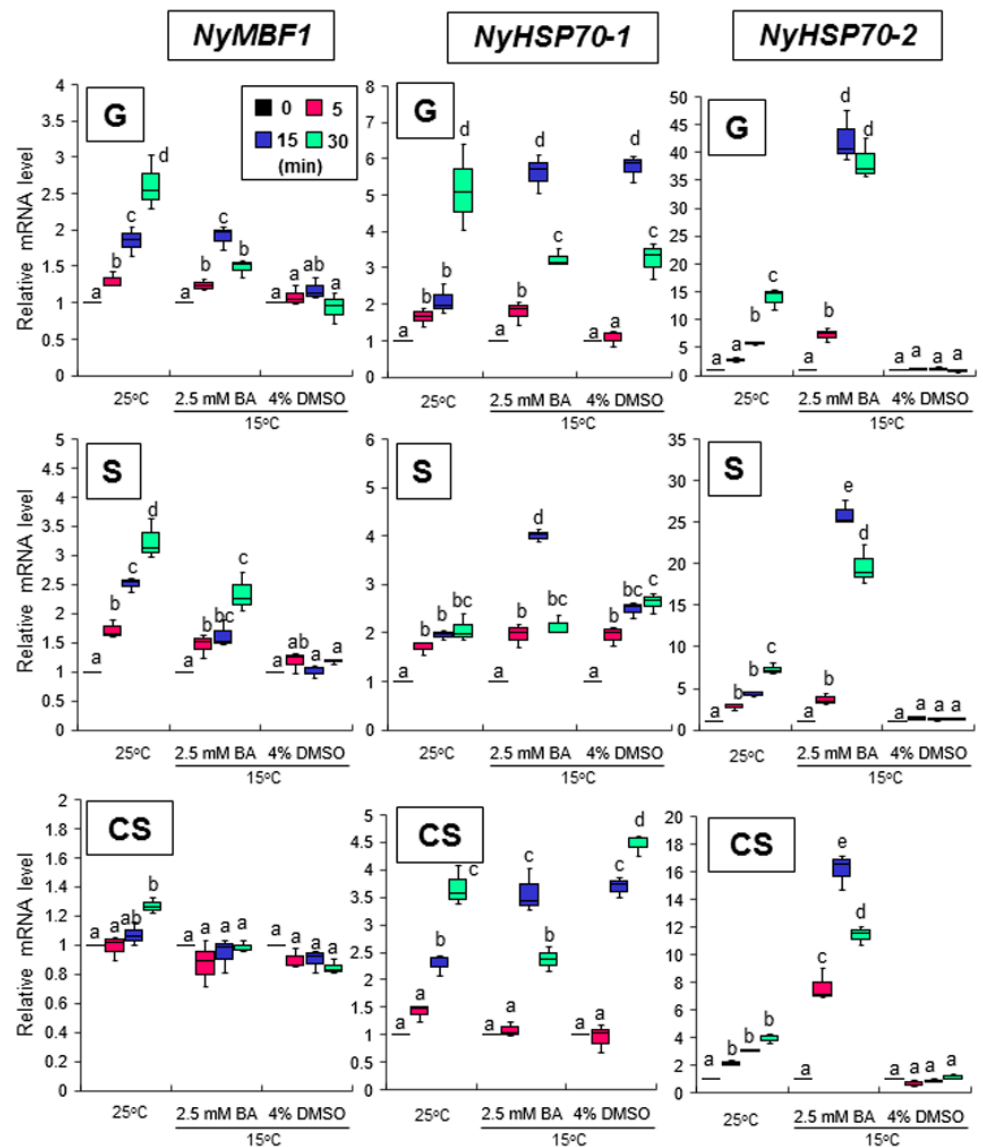
Figure 6. Effects of changes in membrane physical state on NyMBF1 , NyHSP70-1 , and NyHSP70-2 expression in three life cycle generations of Neopyropia yezoensis . The algae were treated with 2.5 mM BA and 4% DMSO at 15 °C for 5, 15, and 30 min, and the expression of NyHSP70-1 and NyHSP70-2 was compared with their expression at 25 °C. Relative mRNA levels were normalized using eIF4A as the reference gene. In the box plots, values on the Y axis represent the fold change of relative quantification of each gene. Different alphabetical letters denote significant differences in expression level among the three life cycle generations from triplicate independent replicates as defined by Tukey’s test ( p < 0.05) in two-way ANOVA. G—gametophyte; S—sporophyte; CS—conchosporophyte.